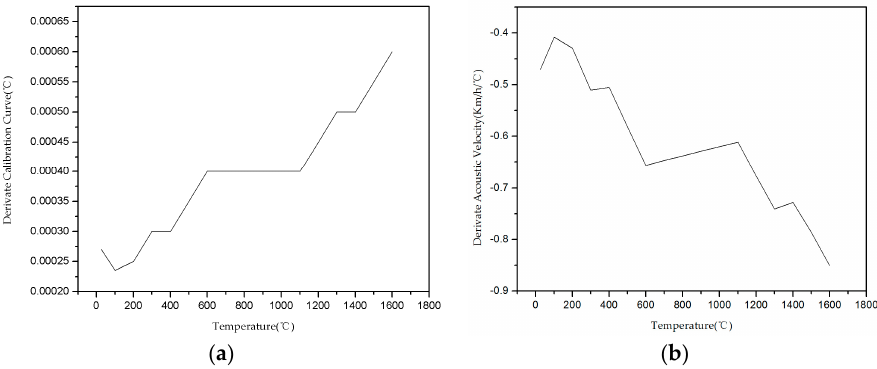
Figure 9. Derivate curves: ( a ) Calibration curve; ( b ) Acoustic velocity curve.